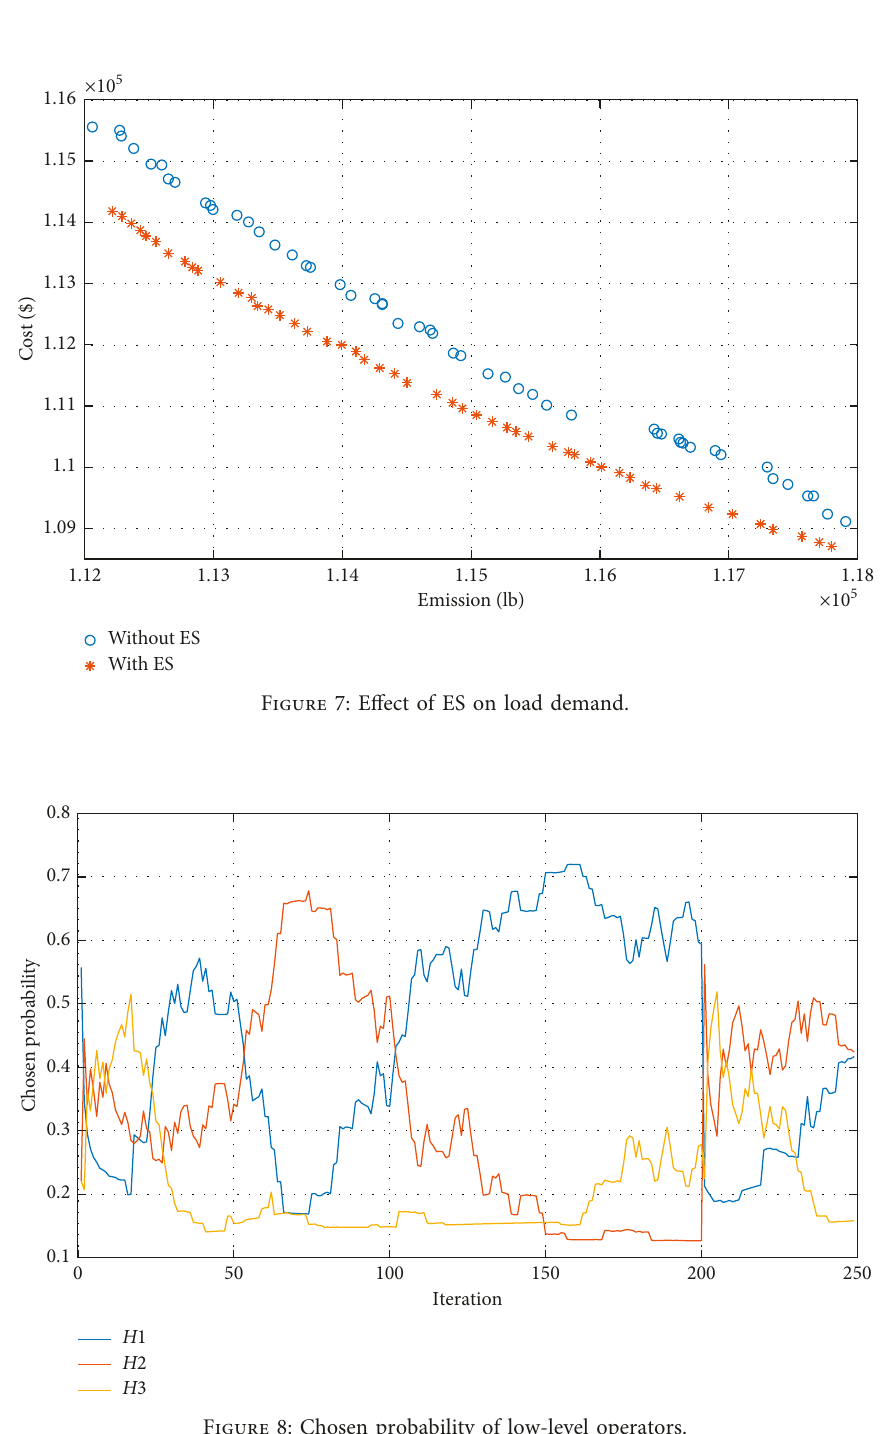
Figure 8: Chosen probability of low-level operators.